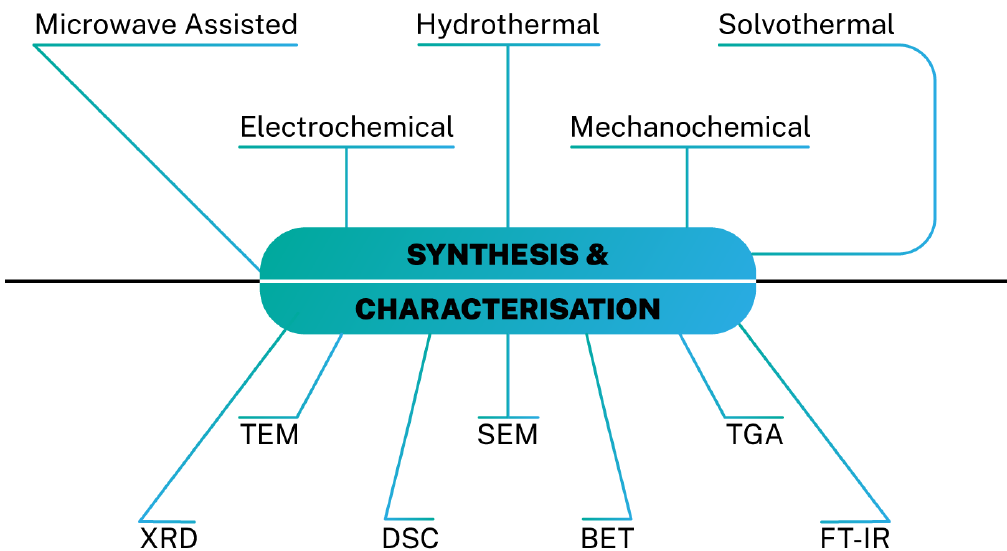
Figure 3. Common synthetic routes for MOFs (above) and characterization techniques (below). TEM: Transmission electron microscopy, SEM: Scanning electron microscopy, TGA: Thermogravimetric analysis, XRD: X-ray diffraction, BET: Brunauer– Emmett–Teller surface area, DSC: Differential scanning calorimetry, FT-IR Fourier transform infrared spectros- copy.